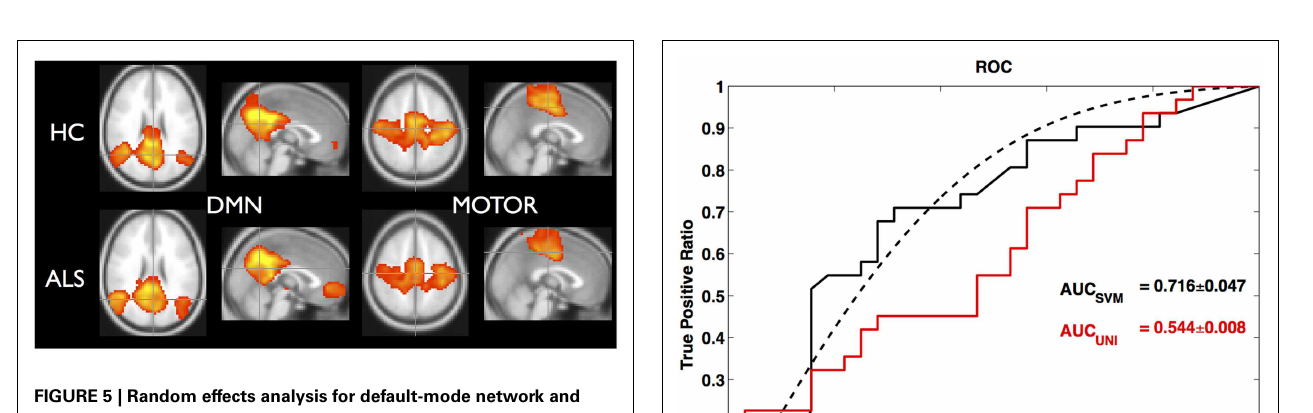
FIGURE 5 | Random effects analysis for default-mode network and motor network . Healthy controls are in top row and ALS are in bottom row. Statistical maps thresholded for t ≥ 3.5 for illustrative purposes.